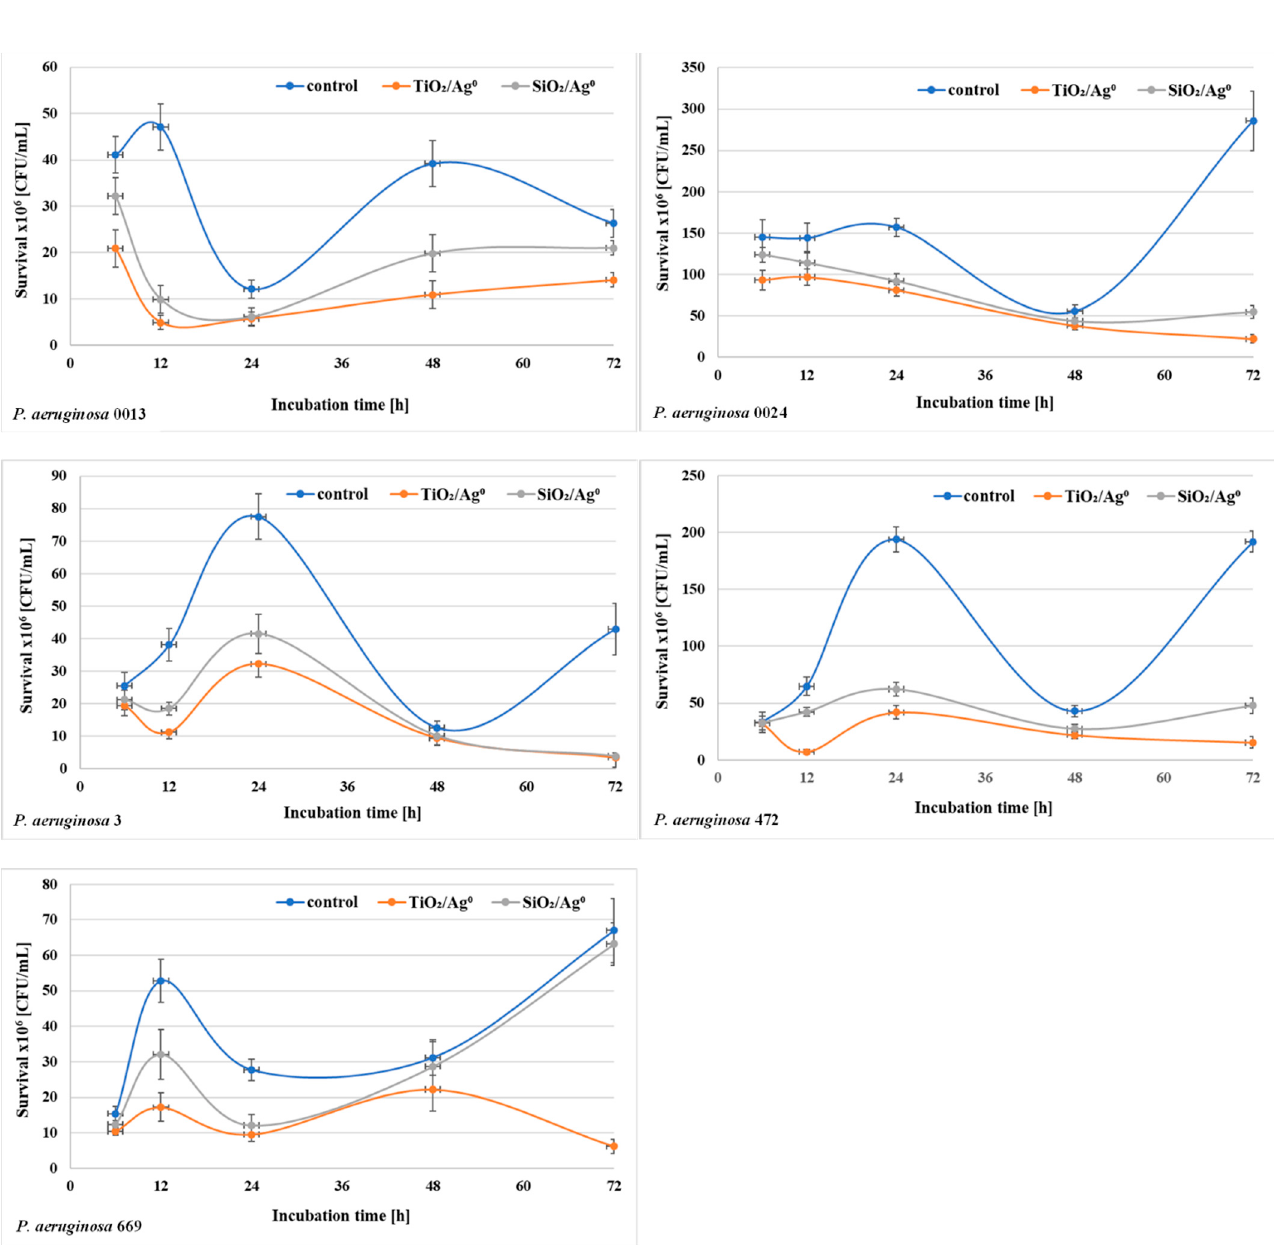
Figure 7. Effect of SiO 2 /Ag 0 and TiO 2 /Ag 0 on the survival of P. aeruginosa strains isolated from bronchoalveolar lavage fluid in biofilm mass.